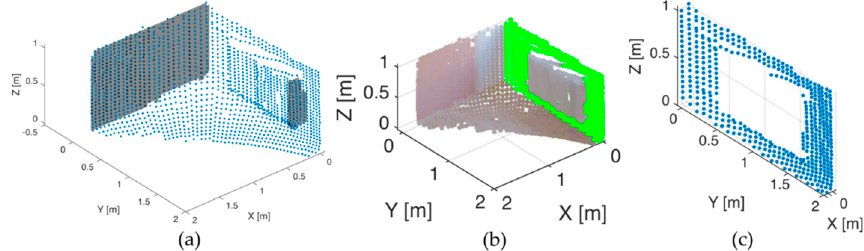
Figure 24. Segmentation of different planar surfaces: ( a ) Illustration of two segmented planar surfaces with different area in Y-axis; ( b ) First level segmentation in X-axis; ( c ) Resultant point cloud.